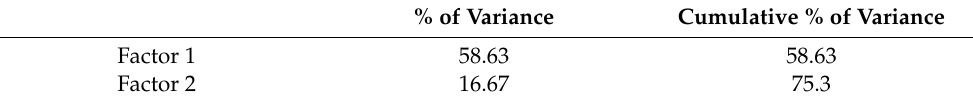
Table 5. Proportion of variance explained by factor analysis of baseline FOT measurements.